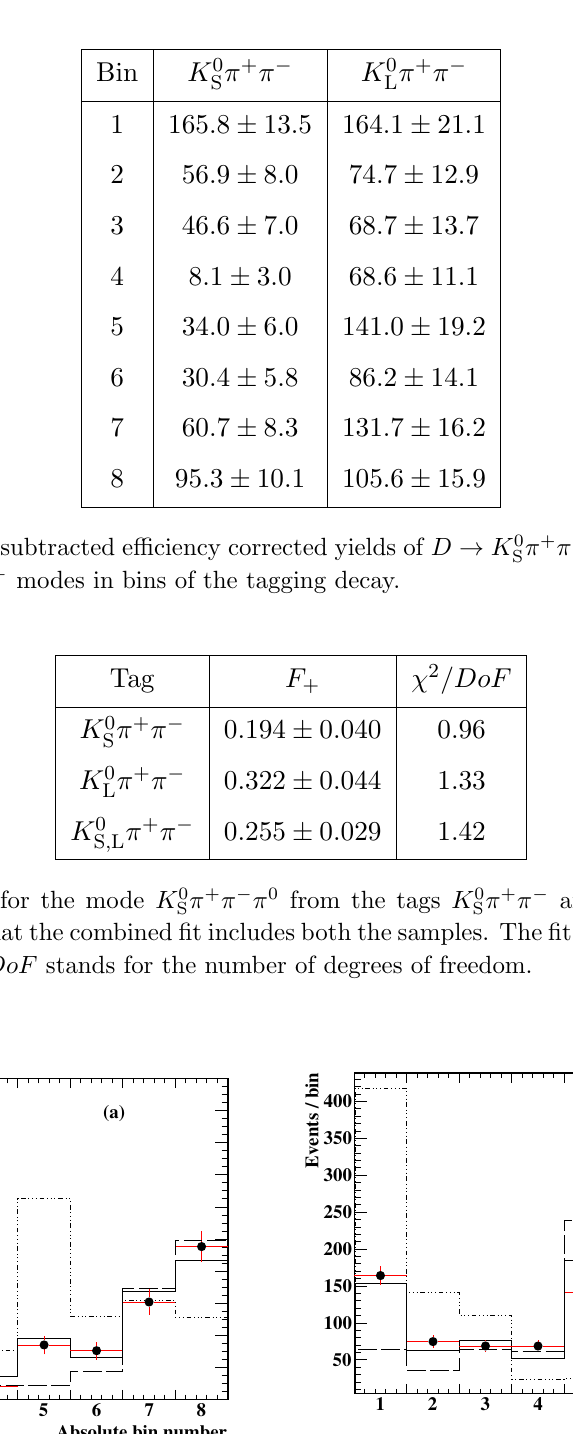
(cid:25) + (cid:25) (cid:0) and (b) K 0 (cid:25) + (cid:25) (cid:0) in each bin obtained S L